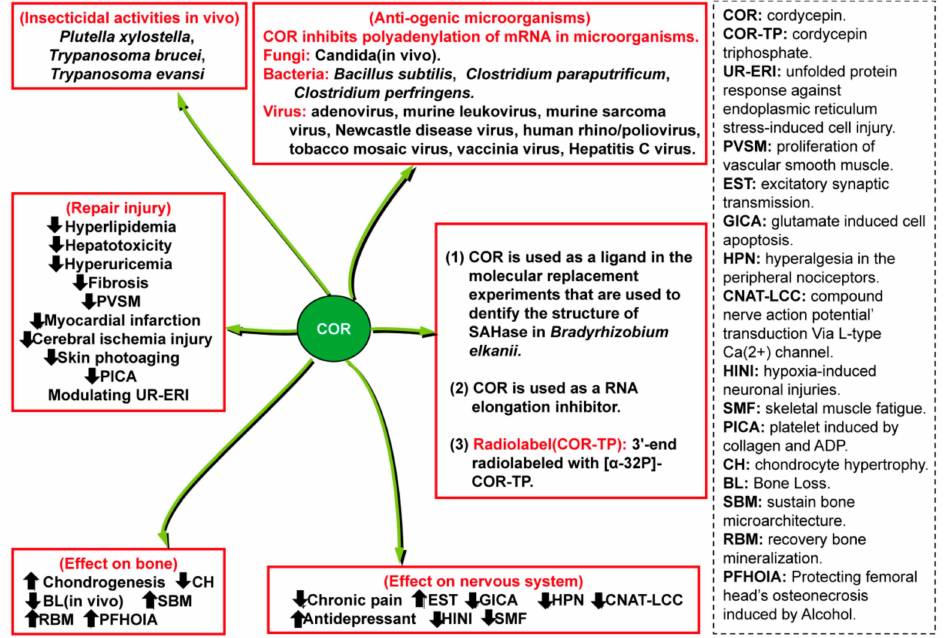
Figure 4. Other medicinal value and biological applications. Note: COR can also inhibit excitatory synaptic transmission [18] and have neuroprotective e ff ects [19]. ER-COR has antiplatelet e ff ects [20]. The [ α -32P]-COR-TP is used for 3 (cid:48) -end radiolabeled RNA fragments